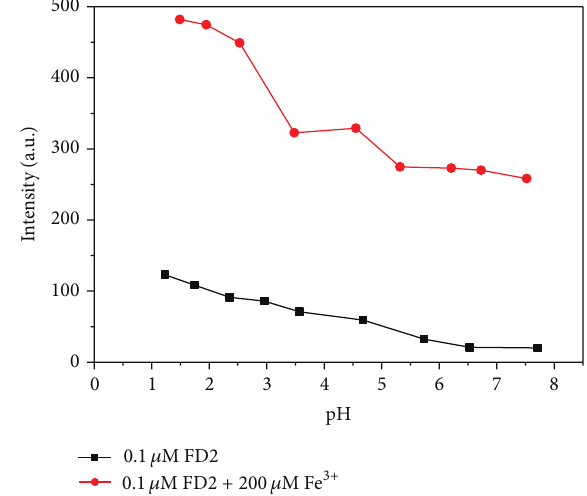
Figure 4: Effect of pH on the fluorescence intensity of 0.1 𝜇 M FD2 in water solution without (a) and with 200 𝜇 M Fe 3+